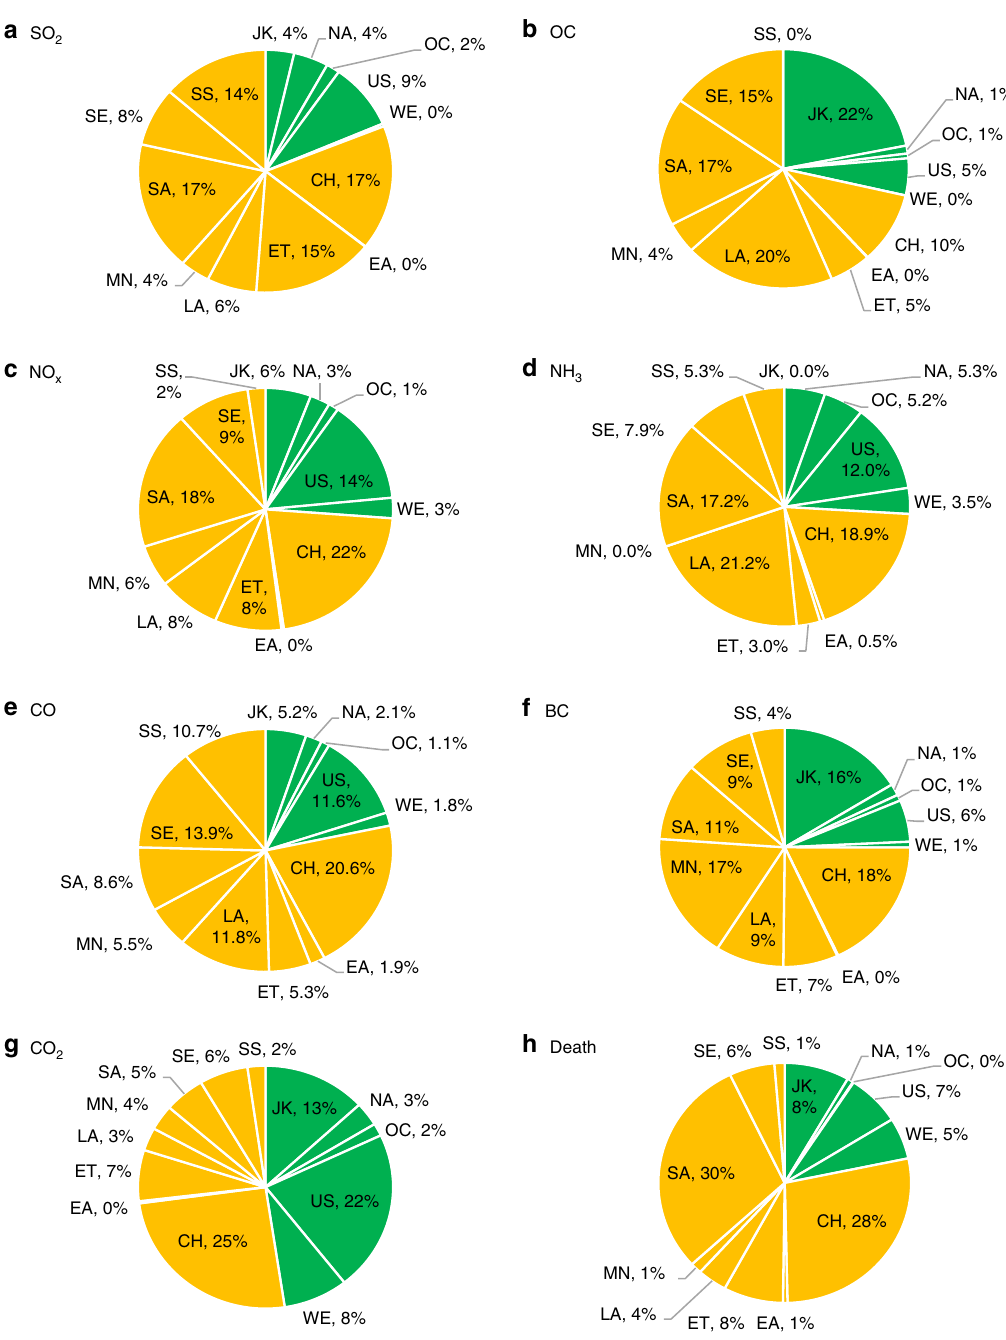
Fig. 3 Regional contributions to global changes in ( a – f ) pollutant emissions and ( g ) CO 2 and ( h ) PM 2.5 related mortality from global free trade scenario (GFT) to global trade barrier (GTB) scenario. The green color represents developed regions, and the orange color represents developing regions. Results here only include scenario-dependent sources. Regions include China (CH), rest of East Asia (EA), Economies in Transition (ET), Japan and Korea (JK), Latin America and Caribbean (LA), Middle East and North Africa (MN), rest of North America (NA), Oceania (OC), South Asia (SA), South-East Asia and Paci fi c (SE), Sub-Saharan Africa (SS), the United States (US), and Western Europe